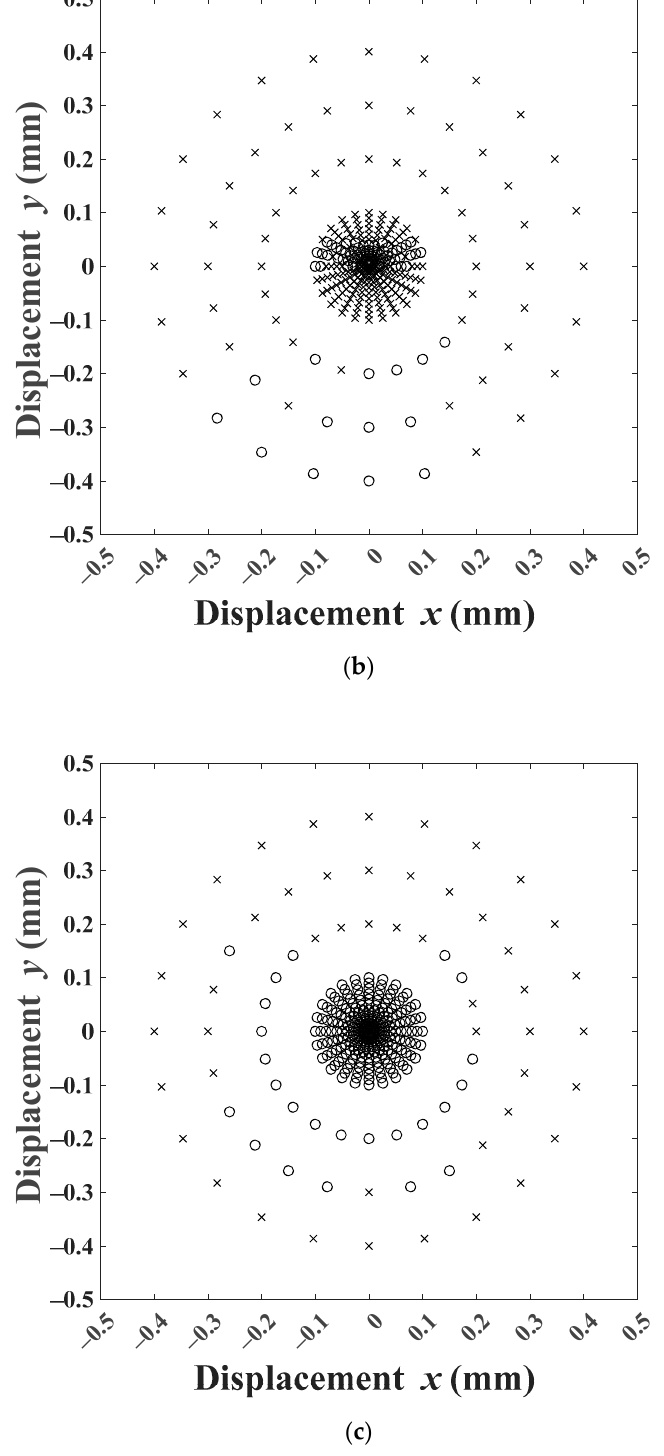
=ω =ρ 0.06 mm and 250